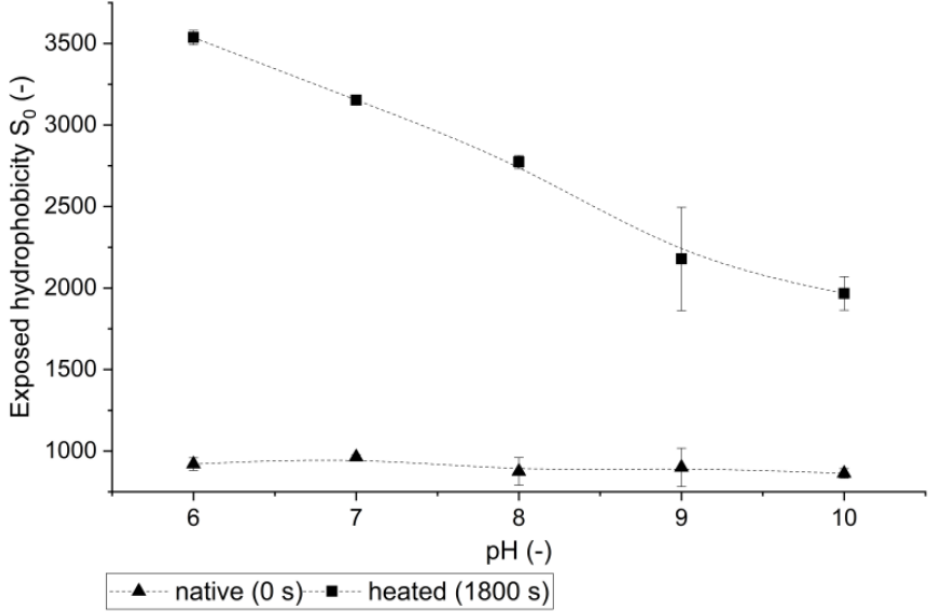
Figure 9. Exposed hydrophobicity of a 1% PPI solution native (unheated) and heated for 1800 s above T d , in dependence of the pH.